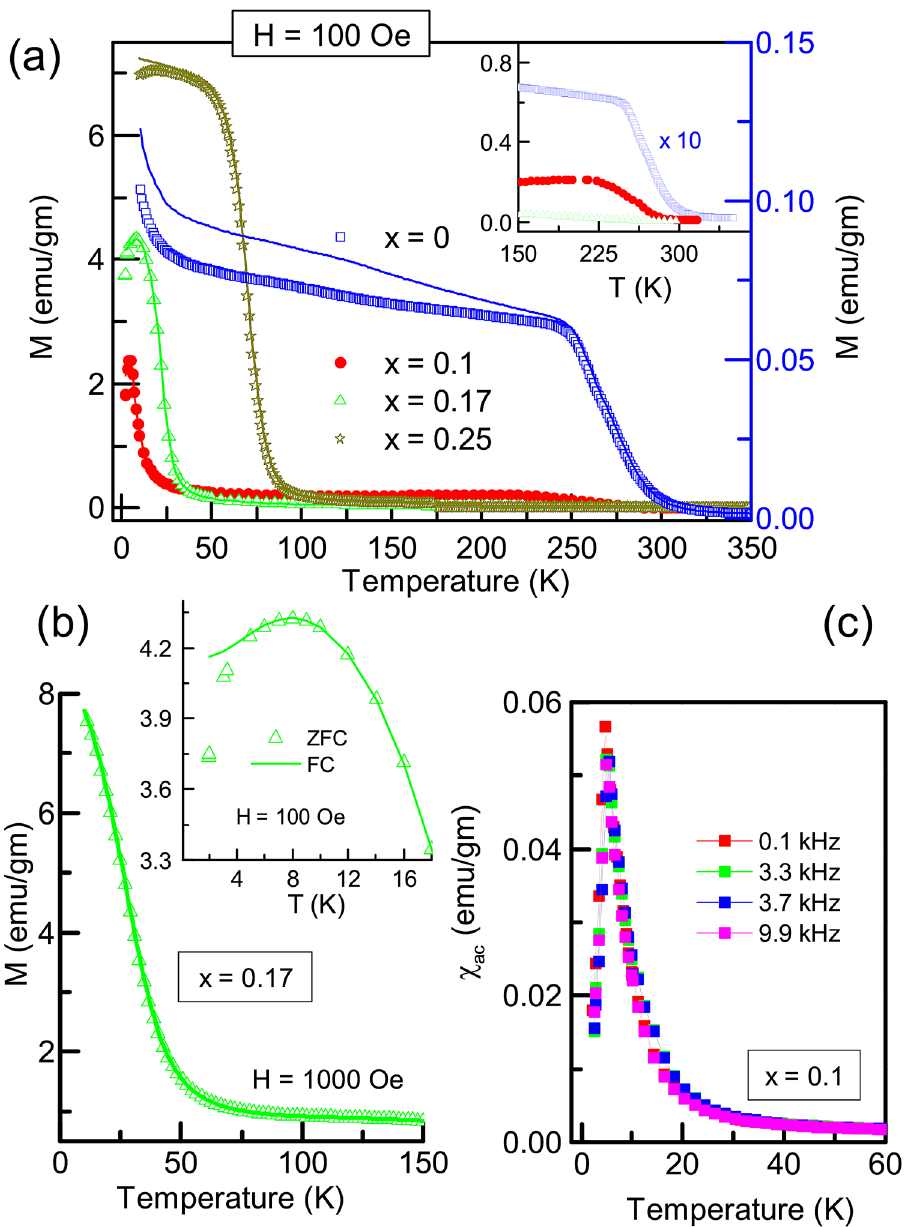
Figure 2. Magnetization vs. temperature measured in ZFC (symbols) and FC (line) protocols: ( a ) measured in an applied field of 100 Oe. The inset here shows systematic suppression of magnetic cluster formation with increasing Cr-substitution. ( b ) measured with an applied field of 0.1 T, and the inset showing ZFC/FC bifurcation for data recorded with H = 100 Oe. ( c ) Low temperature χ ac measured at different frequencies for a nominal